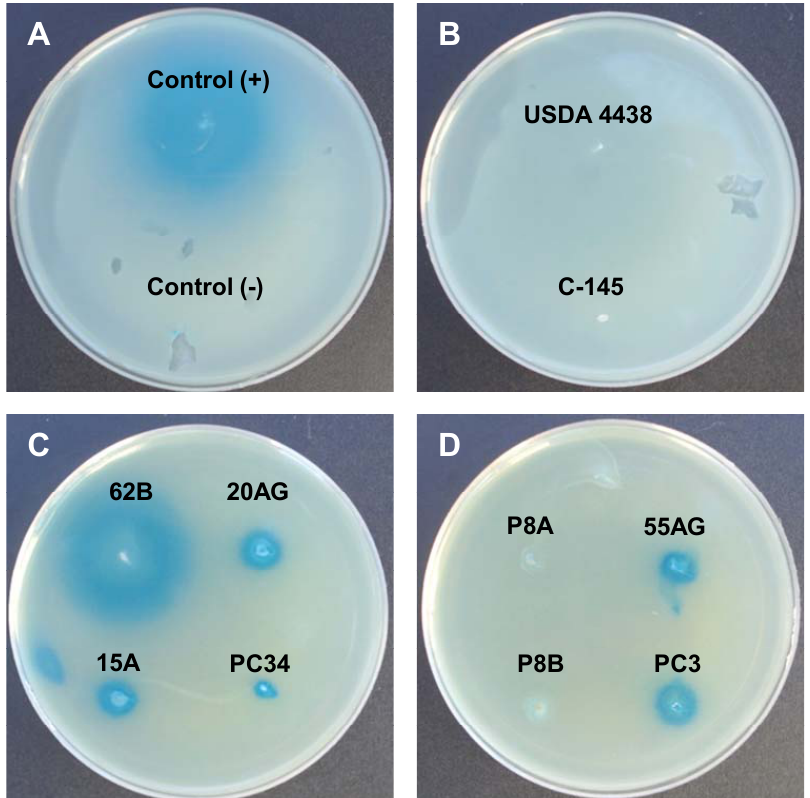
Figure 1. Bioassay for detection of AHL-like molecules with long acyl chains using A. tumefaciens NTL4 (pZLR4) as biosensor